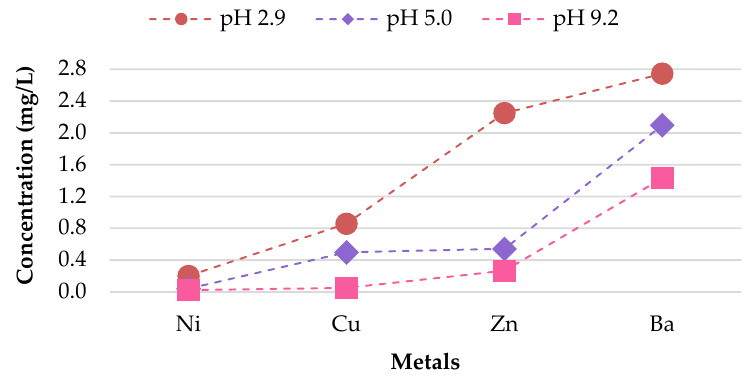
Figure 17. Variable relationship observed between metal concentrations leached from 2% CB bricks and pH value.